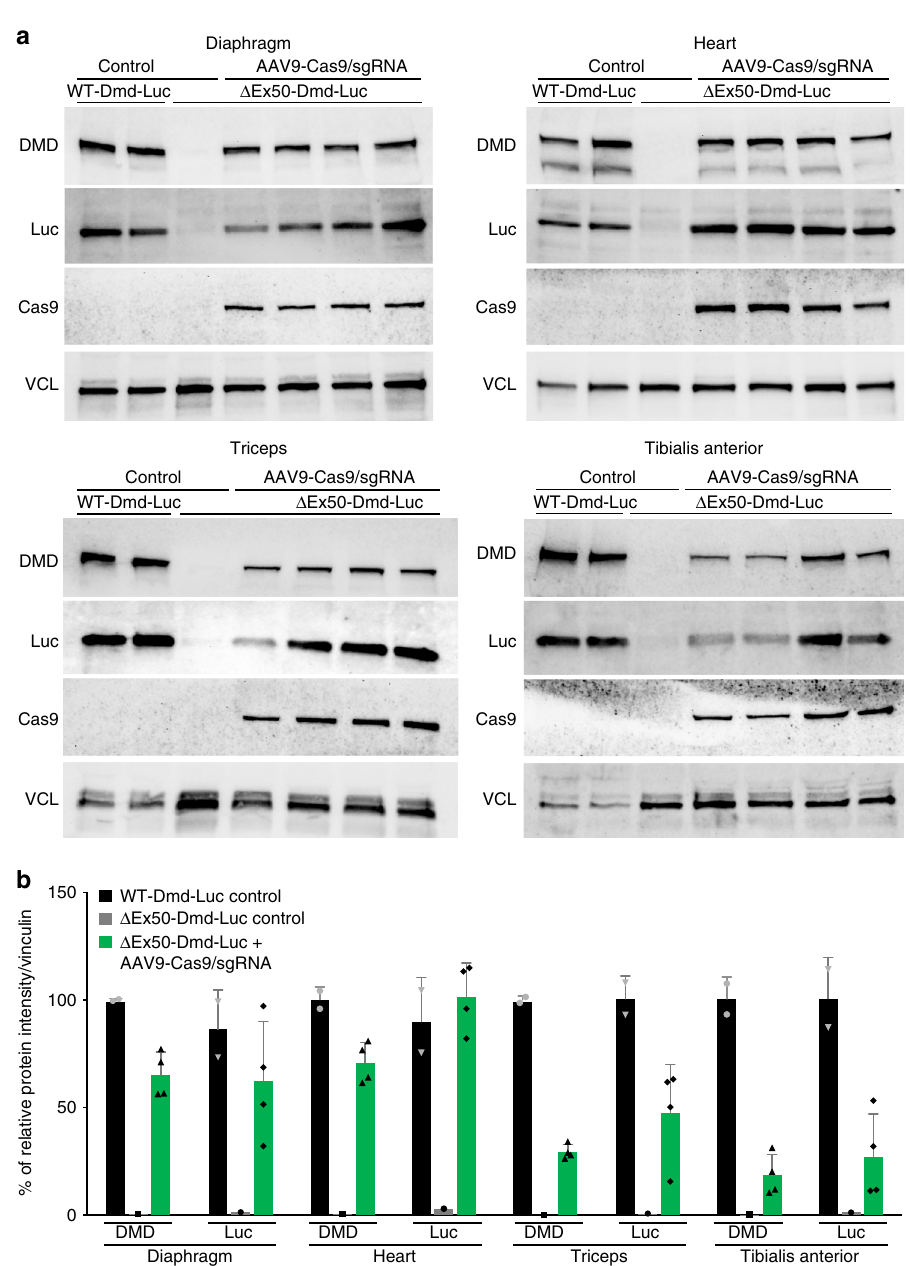
Fig. 4 Expression of dystrophin and luciferase following systemic delivery of AAV9-encoded gene editing components. a Western blot analysis of dystrophin (DMD), luciferase (Luc), Cas9, and vinculin (VCL) in diaphragm, heart, triceps muscles, and tibialis anterior of WT-Dmd-Luc mice, control Δ Ex50-Dmd-Luc mice and Δ Ex50-Dmd-Luc mice injected with AAV9-Cas9 and AAV9-sgRNA. b Quanti fi cation of dystrophin and luciferase expression from blots after normalization to vinculin. Data are represented as mean ± SEM. n =